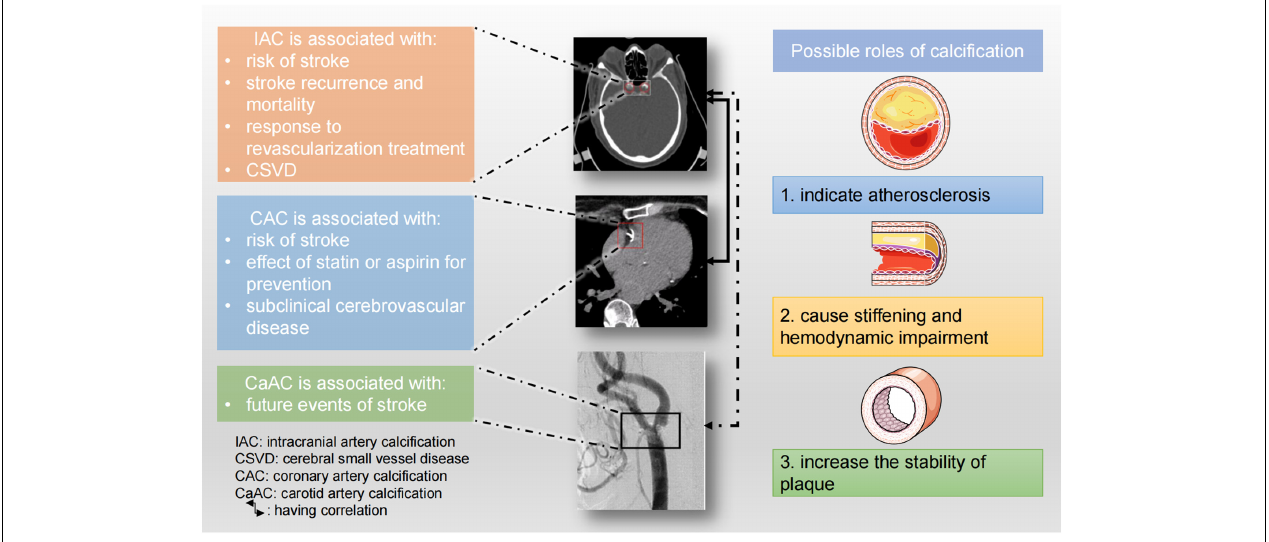
FIGURE 6 | Clinical implications of large artery calcifications and possible roles of vascular calcification. The CT image of IAC was from Rahmani et al. (2022). The CT angiogram of carotid artery calcification was reused with permission of American Society of Neuroradiology, from Tsutsumi et al. (2008); permission conveyed through Copyright Clearance Center,